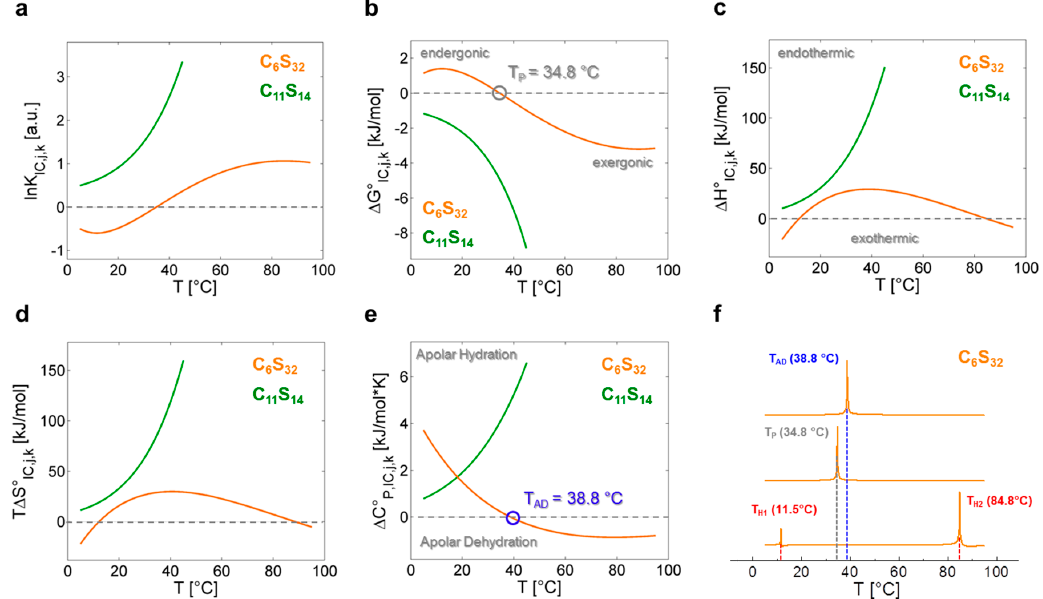
Figure 4. Graphical representation of the thermodynamic functions calculated from ln K IC, j, k . Continuous depiction of ( a ) ln K IC, j , k vs. T from data in Supplementary Tables S2 and S4, Equations (12) and (16), resulting in the ( b ) molar Gibb’s free energy change ∆ G ◦ IC, j , k with performance temperature T P at 34.8 ◦ C (gray), endergonic ( ∆ G ◦ IC > 0) and exergonic ( ∆ G ◦ IC < 0) regions; ( c ) Temperature- dependent change of molar enthalpy ∆ H ◦ IC, j , k calculated from Equations (13) and (17) with endothermic ( ∆ H ◦ IC > 0) and exothermic ( ∆ H ◦ IC < 0) regions; ( d ) Temperature-dependent change of molar entropy T ∆ S ◦ IC, j , k calculated from Equations (14) and (18); ( e ) Change of molar heat capacity ∆ C ◦ P,IC, j , k with the apolar dehydration temperature T AD = 38.8 ◦ C (blue) highlighted, as calculated from Equations (15) and (19). Regions of apolar hydration ( ∆ C ◦ P,IC > 0) and apolar dehydration ( ∆ C ◦ P,IC < 0); ( f ) Determination of T P , T AD and compensation temperatures [4] T H1 and T H2 (red) for polymer C 6 S 32 using the normalized absolute values of the functional ratios [44] | ∆ S ◦ IC, j ,6 / ∆ G ◦ IC, j ,6 |, | ∆ S ◦ IC, j ,6 / ∆ H ◦ IC, j ,6 | and | ∆ H ◦ IC, j ,6 / ∆ C ◦ P,IC, j ,6 | as denoted in Equations (20)–(22). In all figures C 6 S 32 polymer curves are represented in orange and C 11 S 14 polymer curves are in